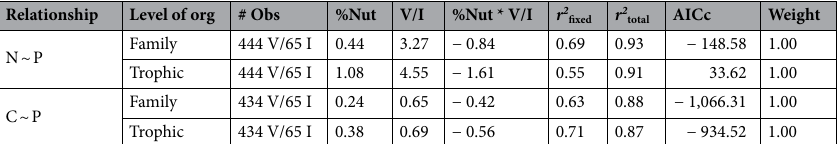
Table 3. Statistics for mixed-effects models of stoichiometric relationships between elements. All models include fixed effects for % body nutrients (% Nut; continuous), vertebrate or invertebrate (V/I; categorical), their interaction (%Nut * V/I), and random effects at either family or trophic group level of organization. Lower AICc scores indicate the better model; r 2 fixed and r 2 total indicate the variation in the data explained by the fixed effects and the full model, respectively. The taxonomic level of classfication that provided by the best model is in bold. Mean parameter estimates are shown for %Nut, V/I, and % Nut *